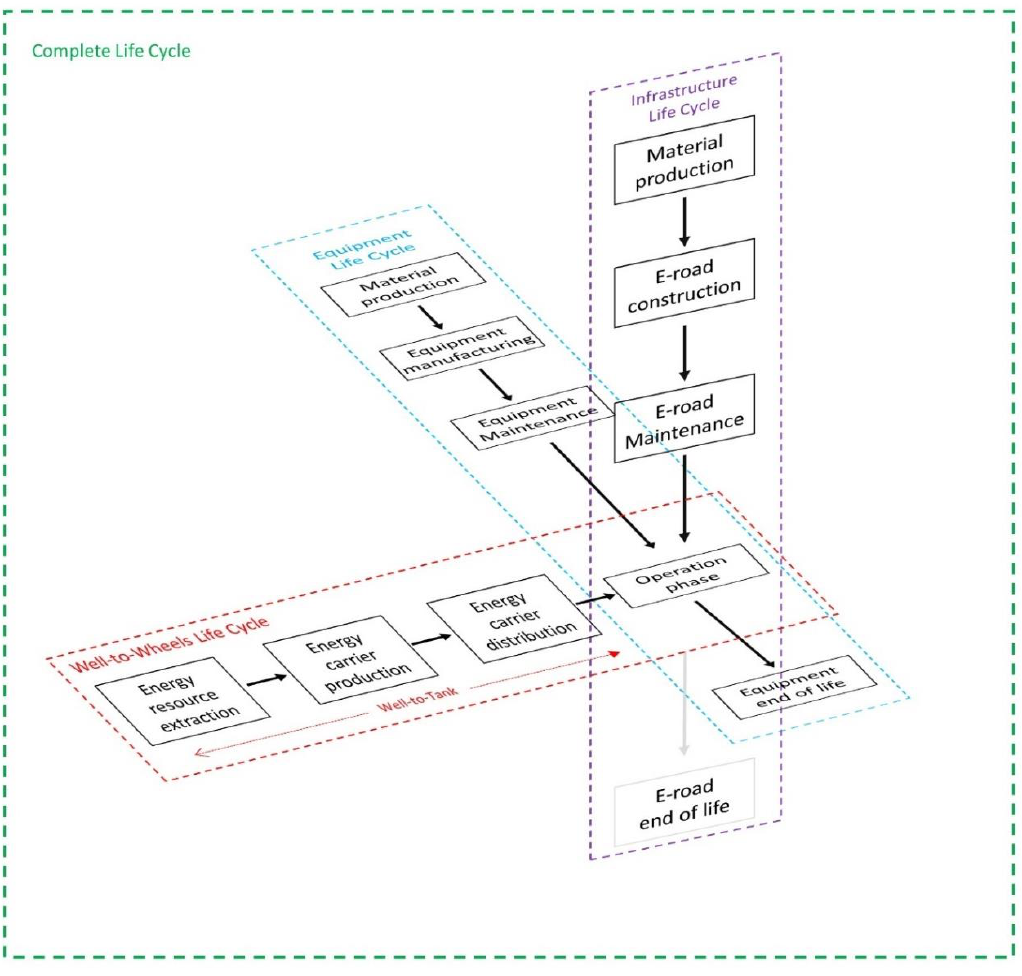
Figure 1. A schematic view of a complete life cycle assessment (LCA) of electric mobility. The impacts of infrastructure of an emerging technology should not be excluded a priori.